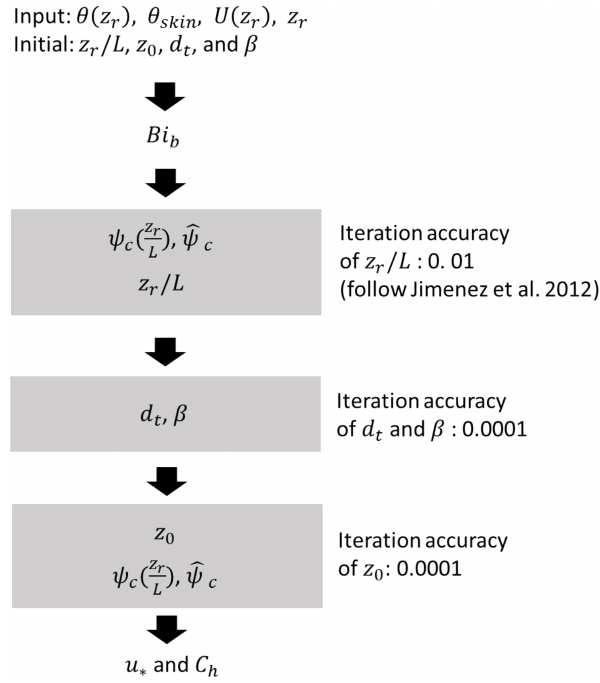
Figure 2. Flow diagram of the RSL parameterization. The gray boxes indicate the iteration module. Table 1. Idealized boundary condition for the one-dimensional of- fline simulation. Constant z 0 is used only in the CTL